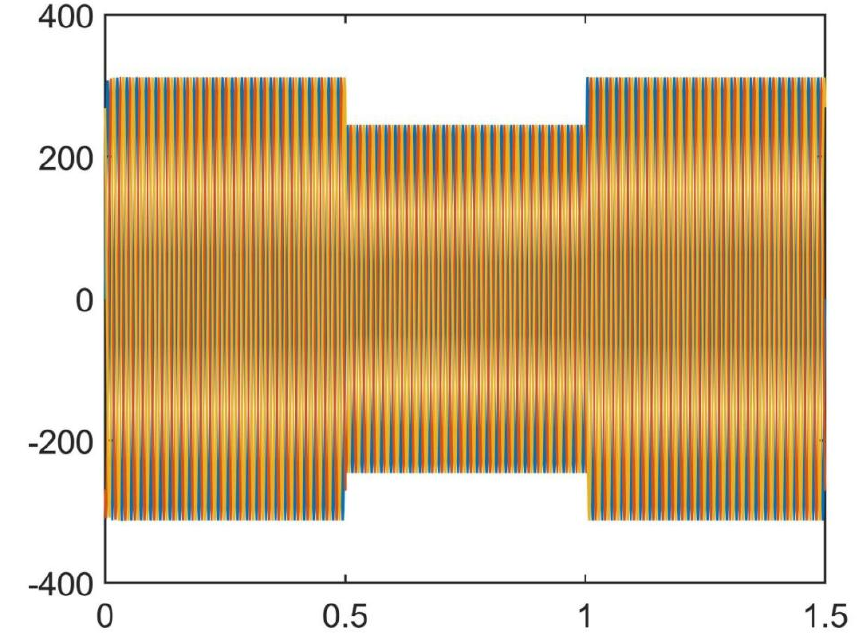
Figure 13. Three–phase voltage waveform when load side changes.